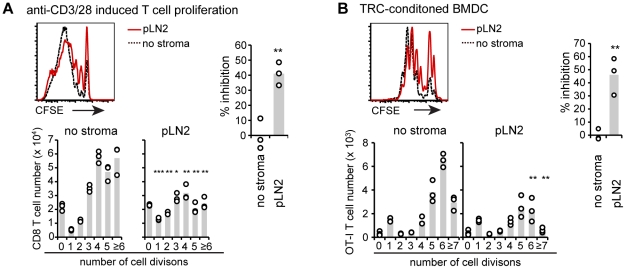
TRC dampen T cell proliferation by modifying both T cells as well as BM-DC.(A) Flow cytometric analysis of T cell proliferation induced by anti-CD3/CD28 beads as based on CFSE dilution after 3 days of culture. WT T cells were cultured with beads and in presence of the pLN2 TRC line (T cell to TRC ratio of 100∶1) or their absence (‘no stroma’). Representative histograms (top) show the percentage (± standard deviation) of divided CD8+ T cells and bar graphs (bottom) the absolute CD8+ T cell numbers per division. The bar graph (right) shows percentage of inhibition (as in Fig. 1). Similar data were obtained for CD4+ T cells suggesting TRC may also suppress their expansion (data not shown). (B) Flow cytometric analysis of cell proliferation induced by TRC-conditioned BM-DC. LPS-activated and SIINFEKL-pulsed BM-DC were co-cultured with pLN2 TRC at a ratio of 1∶1, or cultured alone. After overnight culture TRC-conditioned-BM-DC were re-isolated by MACS, counted and subsequently co-cultured for 3 days with CFSE labeled OT-I cells mixed 1∶50 with unspecific WT T cells (of which 50% are CFSE labeled). Representative histograms (top) show the percentage (± standard deviation) of divided OT-I cells and bar graphs (bottom) the absolute cell numbers per CFSE dilution peak. Percentage of inhibition (as in Fig. 1) is shown in the bar graph on the right. (A,B) n = 3, (A) representative for ≥3 experiments, (B) representative for 2 experiments. * P<0.05, ** P<0.01, *** P<0.001, if not indicated otherwise P-values are relative to ‘no stroma’.